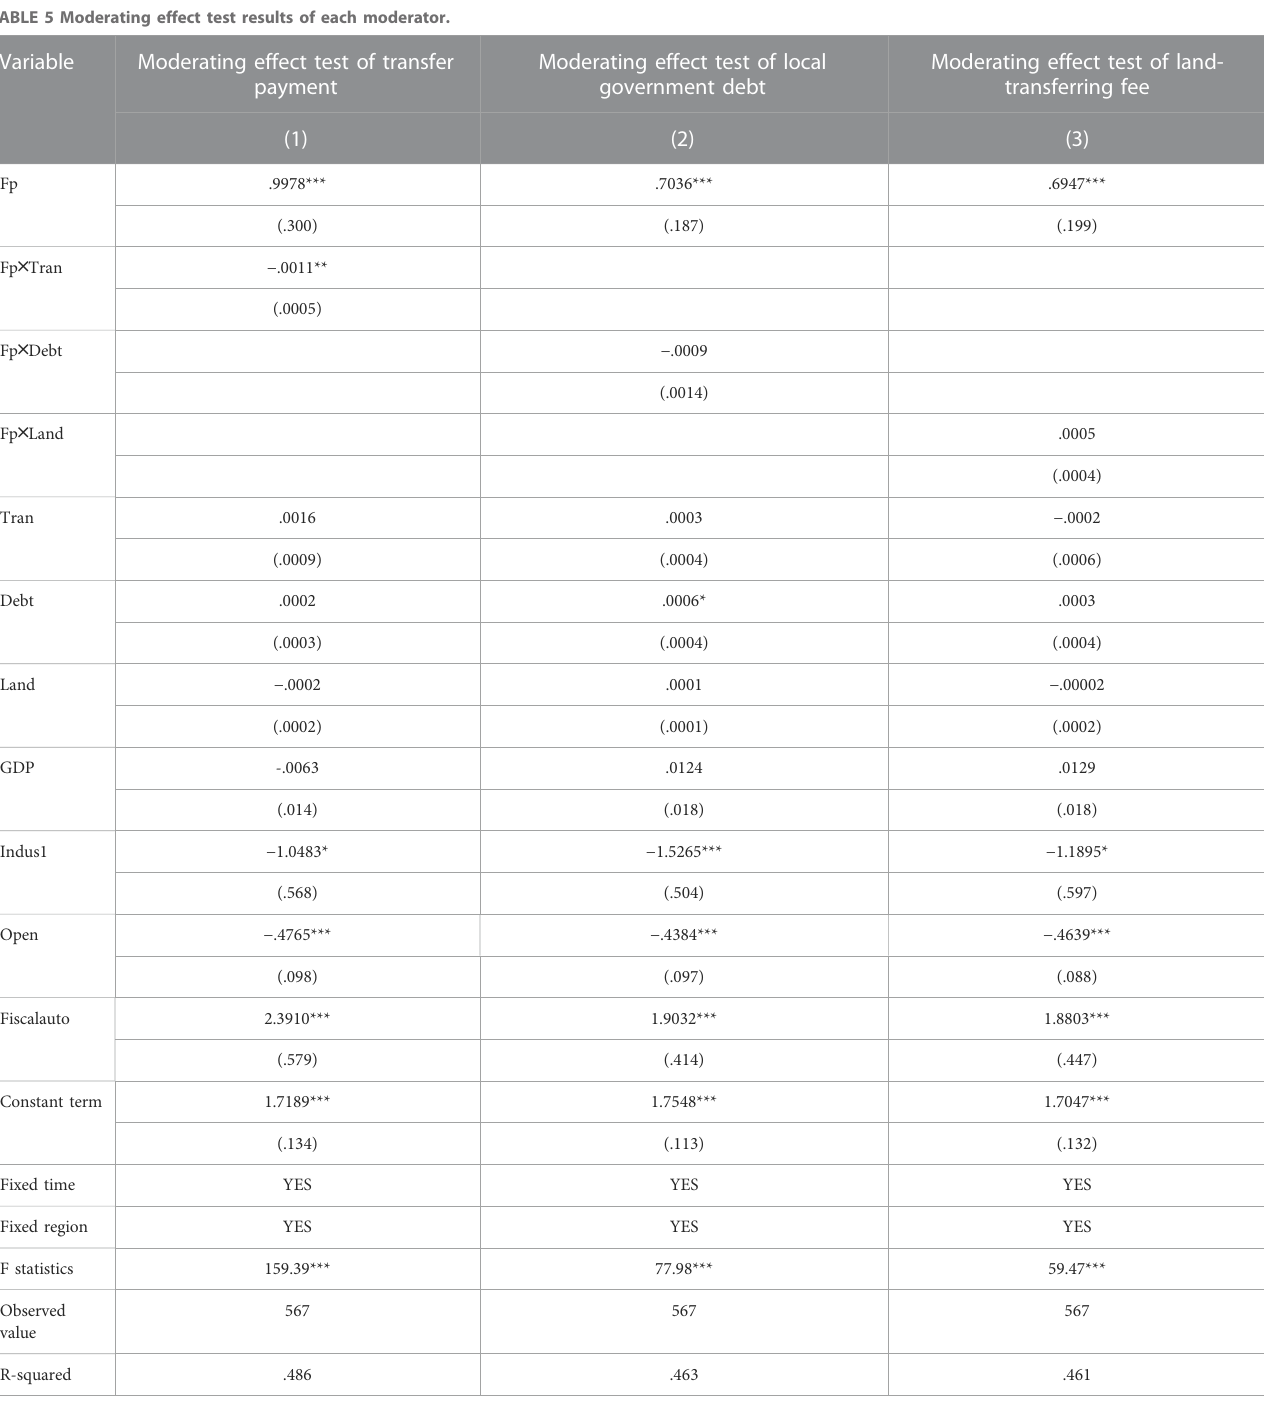
TABLE 5 Moderating effect test results of each moderator.